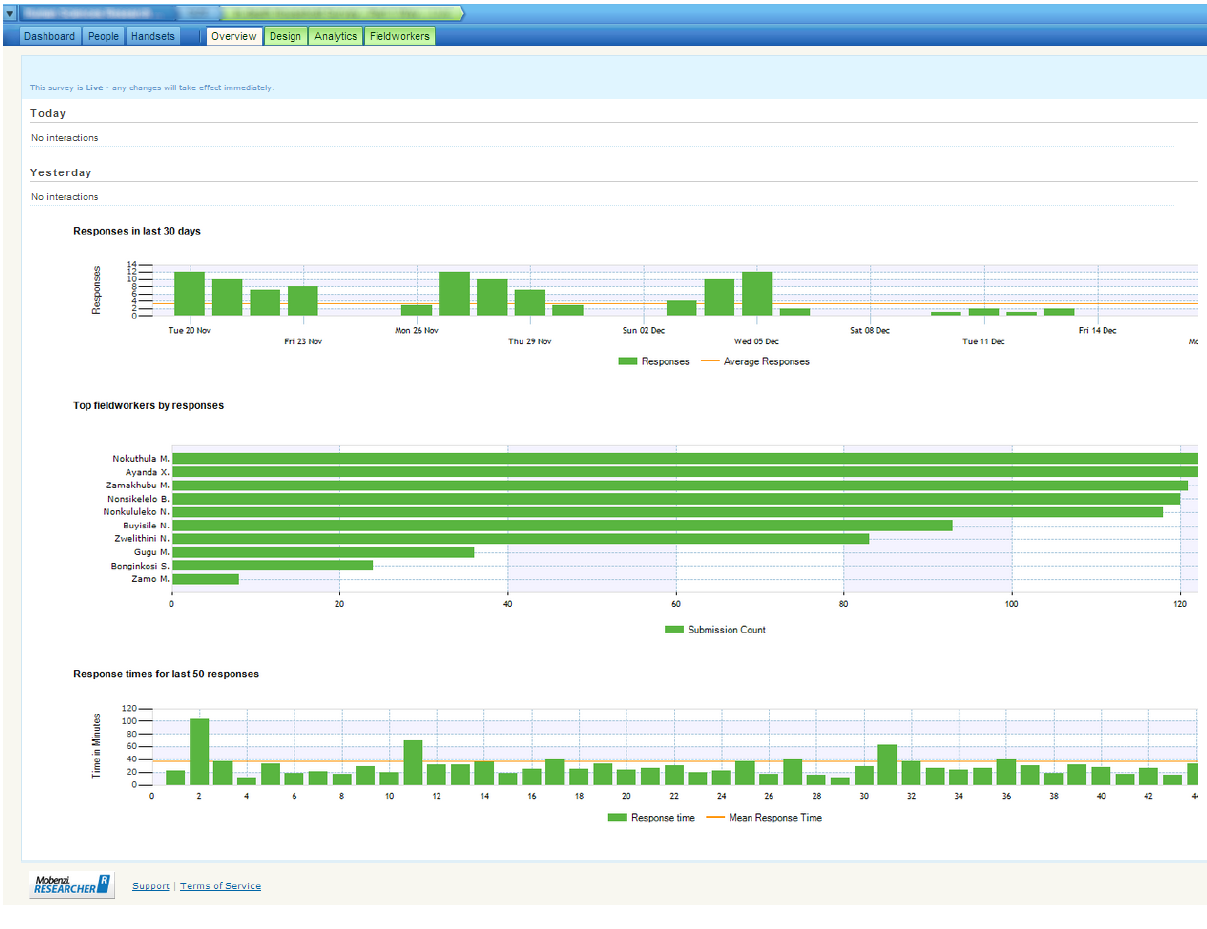
Figure 3. Example of Mobenzi Researcher Web portal: interviewer management.